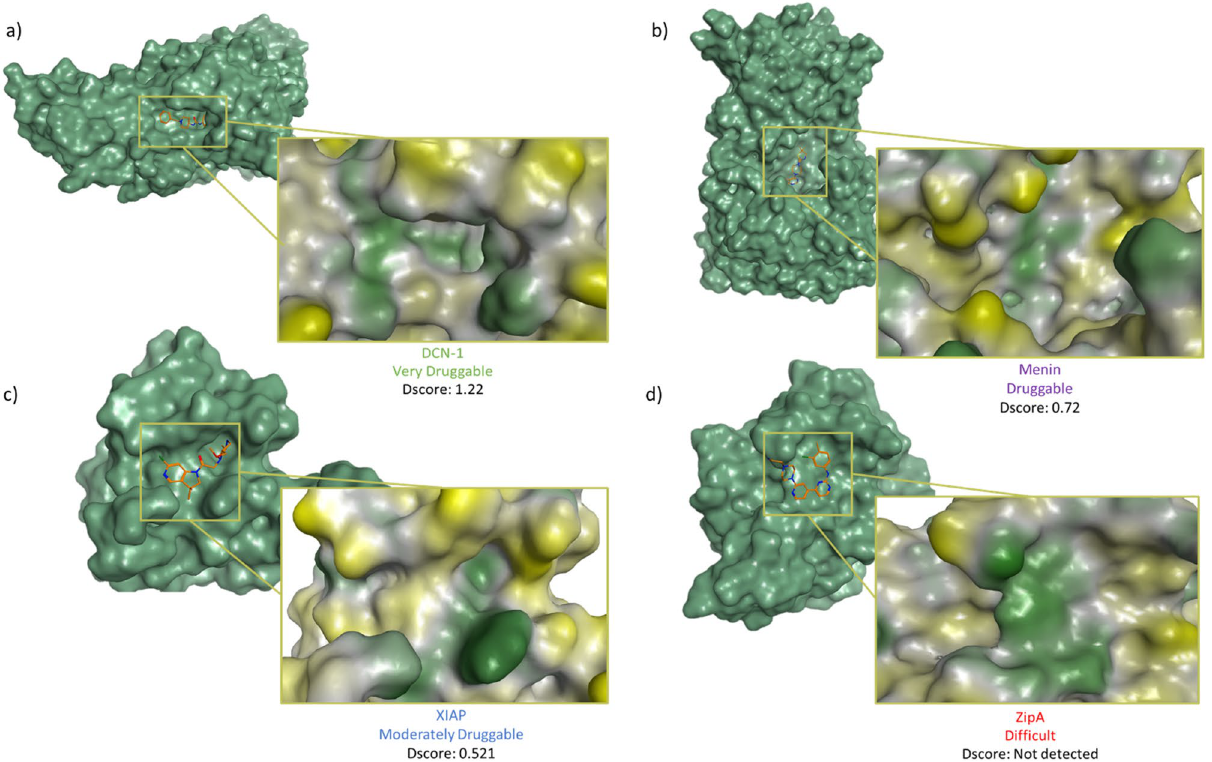
Figure 4. The binding sites of the four classes of PPI illustrated on the surface of a representative example. Surface colored generated using MOE Pocket coloring: green = hydrophobic, yellow = hydrophilic, and grey = neutral. ( a ) The crystal structure of DCN-1 with NAcM-HIT (PDB: 5V83 35 ). ( b ) The crystal structure of Menin with MI-273 (PDB: 5DDF 36 ). ( c ) The crystal structure of XIAP with compound 20 (PDB: 5C84 37 ). ( d ) The crystal structure of ZipA with inhibitor DB03916 (PDB: 1Y2F 38